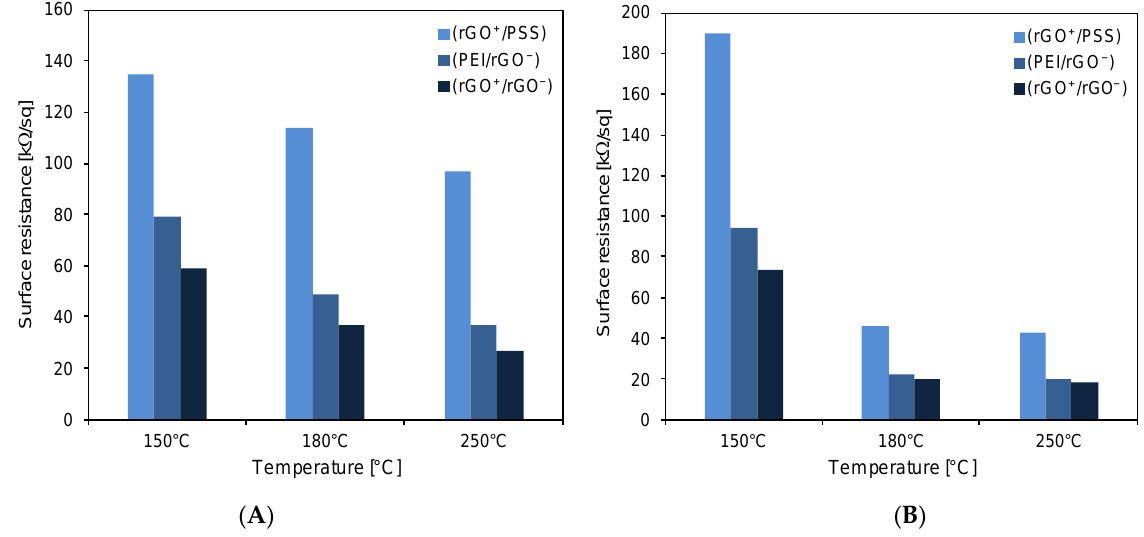
Figure 7. Dependence of the surface resistance values on the reduction temperature for (rGO + /PSS), (PEI/rGO − ), (rGO + /rGO − ) films formed by 11 deposition cycles on quartz plate ( A ) and polyimide foils ( B ).